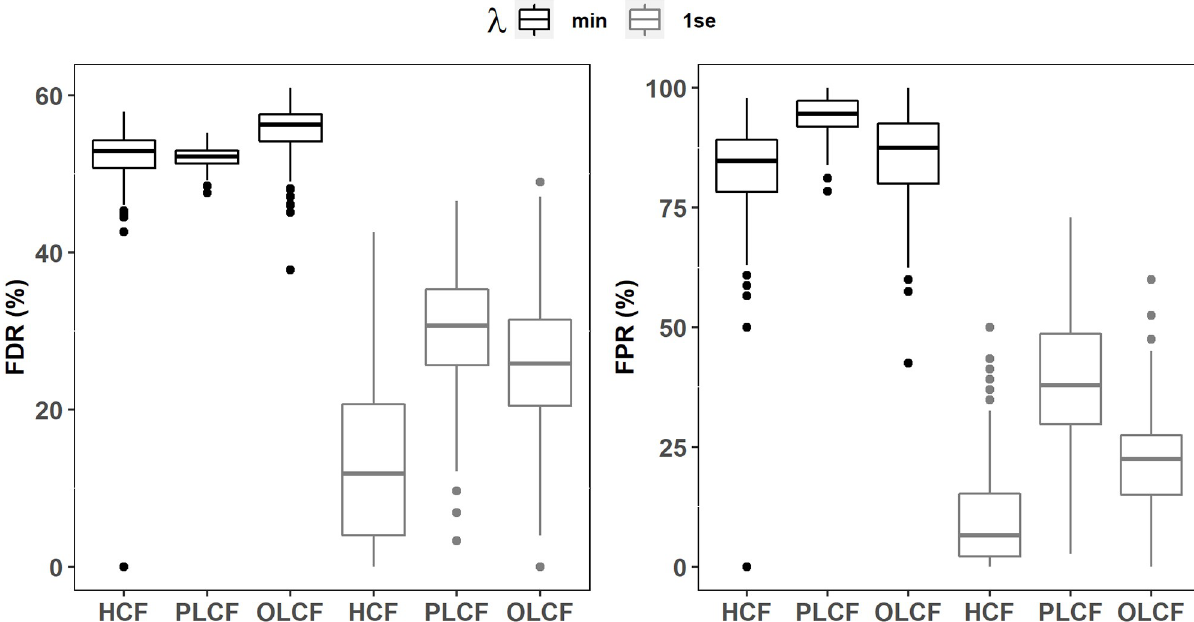
Fig 9. Lasso regularization-based distributions of FDR and FPR for variable selection performed across 500 individual model fits to permuted and balanced wildland fire occurrence datasets.